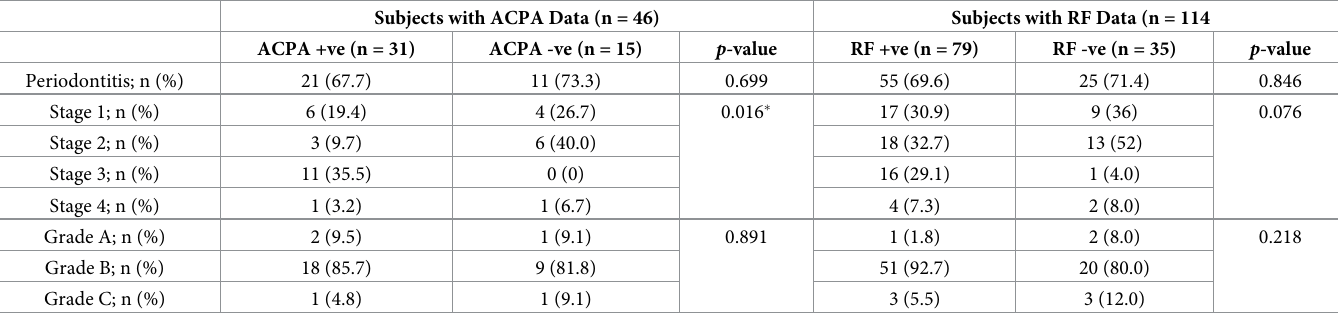
Table 4. Diagnosis, stage and grade of periodontitis according to ACPA and RF status for RA